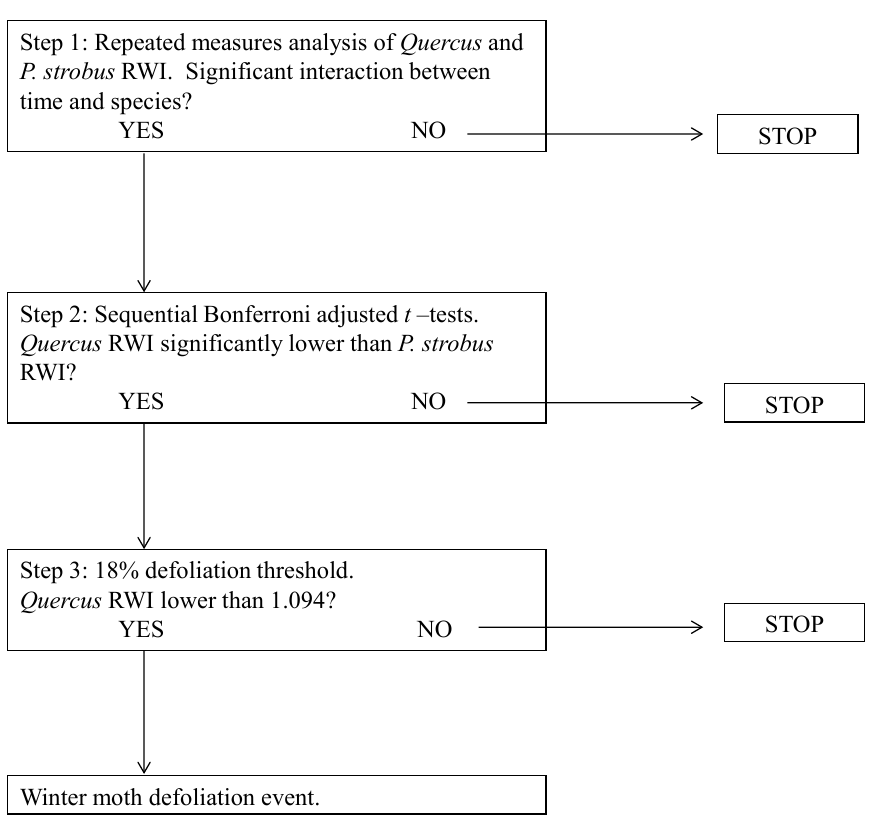
Figure 1. Winter moth defoliation event criteria decision